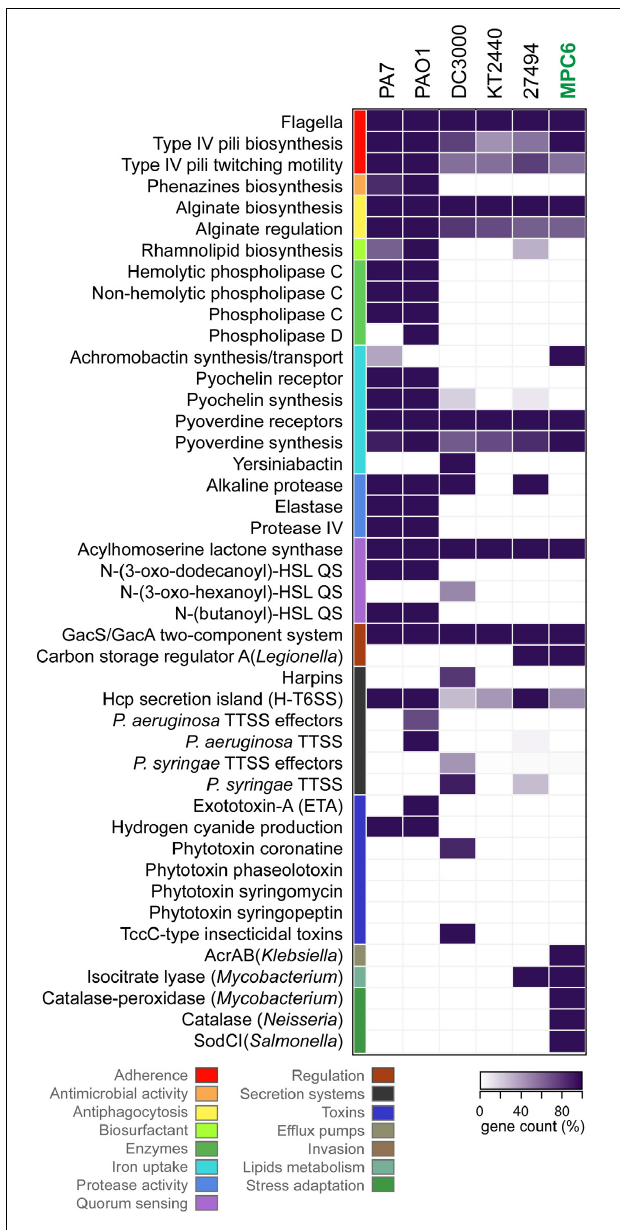
FIGURE 5 | Genome virulence profile of Pseudomonas sp. MPC6 and other pathogenic and non-pathogenic Pseudomonas strains. Putative virulence-associated genes encoded in the genome of each strain were identified, classified and counted using the resources available at VFDB and PATRIC databases. Virulence factors were grouped into functional categories that are depicted with different colors. The gene count for each category in each strain was plotted as a heatmap, were the darkest tone (100%) corresponds to the highest number of genes found in each category among all the